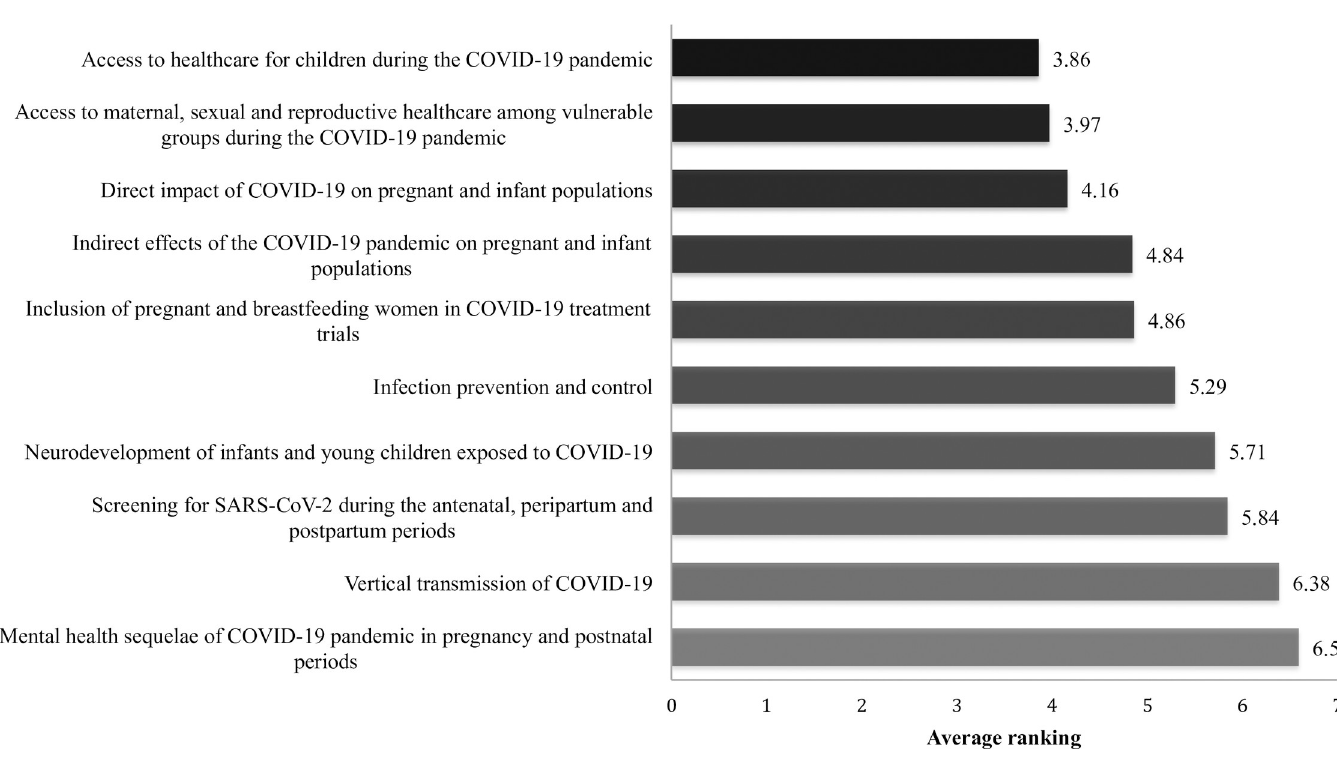
Fig 3. Average rankings of the MNCH research priorities included in Questionnaire